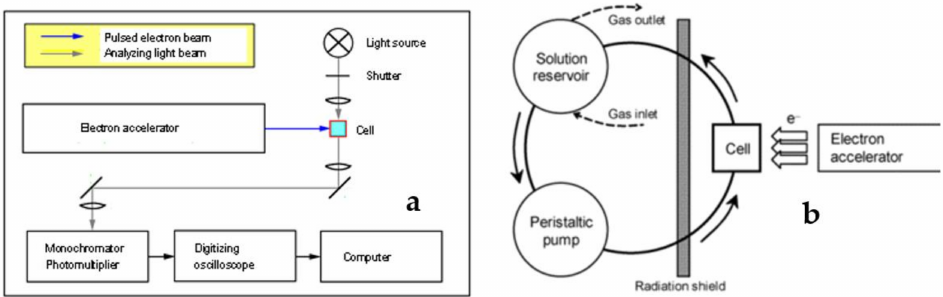
Figure 9. ( a ) Scheme of a simple pulse radiolysis setup with spectrophotometric detection, used in kinetic studies; ( b ) Scheme of a preparative pulse radiolysis system used for synthesizing nanogels. Adapted with permission from [59]; published by American Chemical Society,